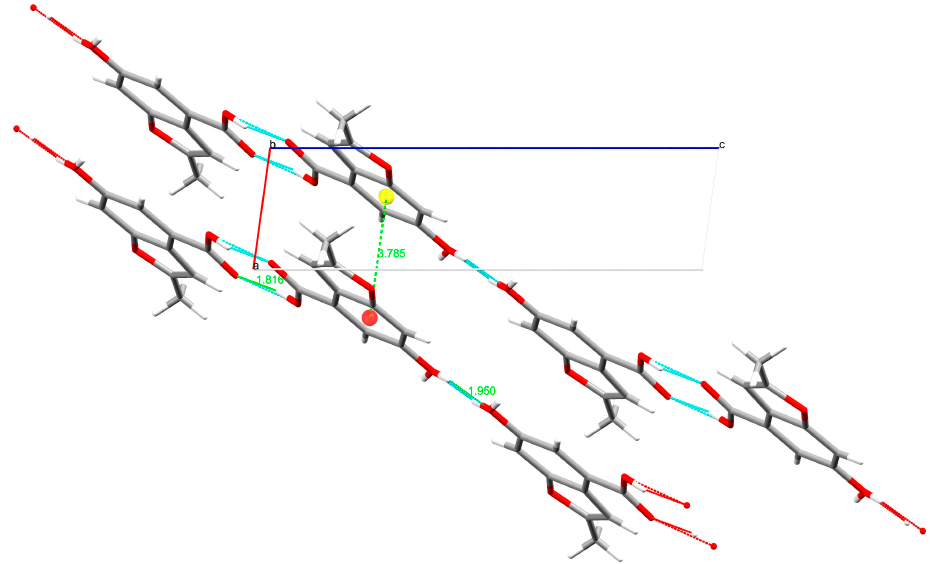
Figure 3. Crystal packing of 1 , viewed along the b axis. The dashed lines show the intermolecular contacts of the compound, while the colored spheres represent the centroids of the rings. Table 1. Hydrogen-bond geometry of 1 (arbitrary atom-numbering scheme used in Figure 2).